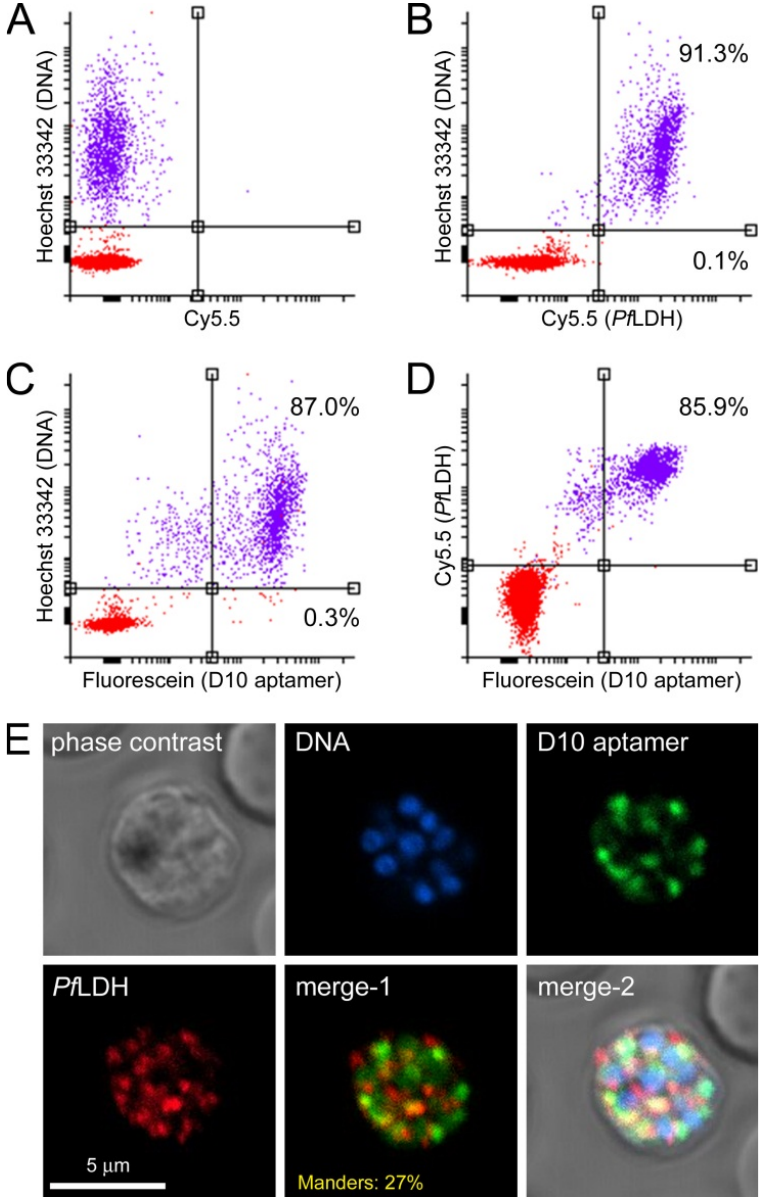
Figure 7. Colocalization study in P. falciparum of D10 and Pf LDH detected with the 2008s aptamer. ( A – D ) Flow cytometry analysis of ( B ) Pf LDH, ( C ) D10, and ( D ) both molecules together. The axis scales indicate relative fluorescence arbitrary units. Panel ( A ) shows a control with Hoechst 33342 DNA staining only. Percentages in panels ( B , C ) indicate the fraction of labeled cells relative to the total number of ( upper panels ) pRBCs and ( lower panels ) non-infected RBCs. The percentage in panel ( D ) indicates the fraction of cells positive for D10 and Pf LDH relative to the total cells positive for D10 or Pf LDH. ( E ) Confocal fluorescence microscopy analysis (merge-1: red and green channels; merge-2: all channels). The Manders’ overlap coefficient is indicated in the merge-1 panel .